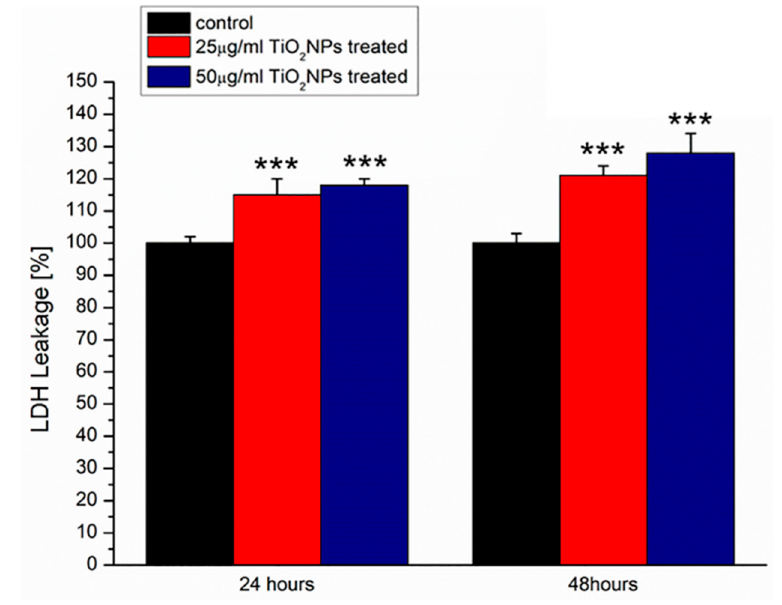
Figure 4. Lactate dehydrogenase (LDH) assay on MCF-7 cells incubated with 25 and 50 µ g / mL of TiO 2 NPs at 24 and 48 h. Percentage of LDH leakage of nanoparticle-treated cells are expressed relative to non-treated control cells. Positive controls (P) consisted of the treatment of cells with 0.9% Triton X-100 showing ca. 500% LDH increase (not shown). Data are reported as mean ± SD from three independent experiments; the statistical significance respect to the control ( n = 8) was represented (*** p -value < 0.005).